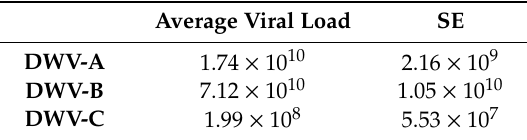
Table 2. Mean apiary level DWV viral load and standard error (SE), per variant in U.S. colonies.